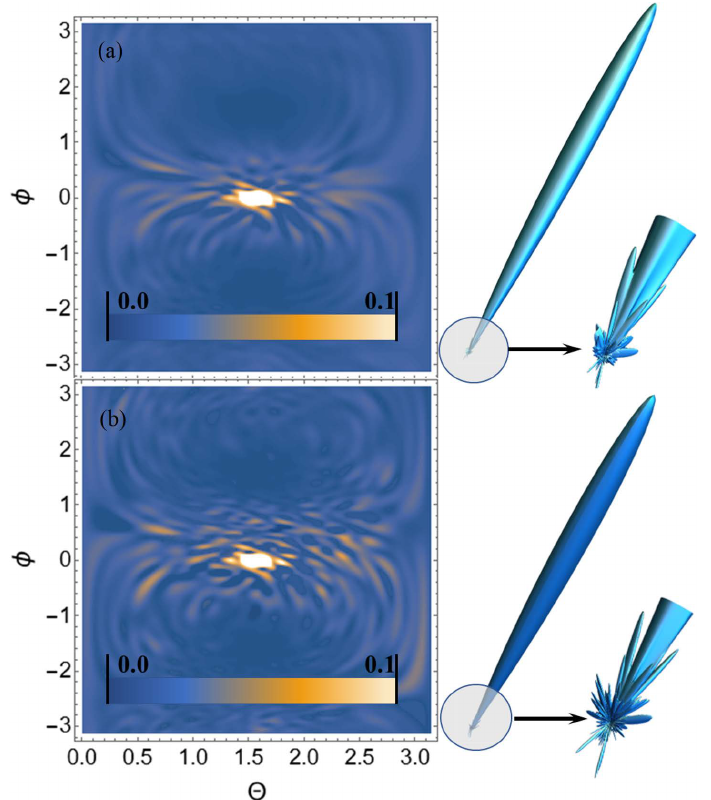
Figure 5. USP scattering spectra on the CAG trinucleotide: ( a ) calculated using Equation (4), ( b ) cal- culated by Equation (1). The spectra are presented as 2D ( left ) and 3D ( right ) plots. The 2D plots are presented in dimensionless units and normalised to the maximum value of the spectrum. The angles φ , θ are spherical angles in the coordinate system shown in Figure